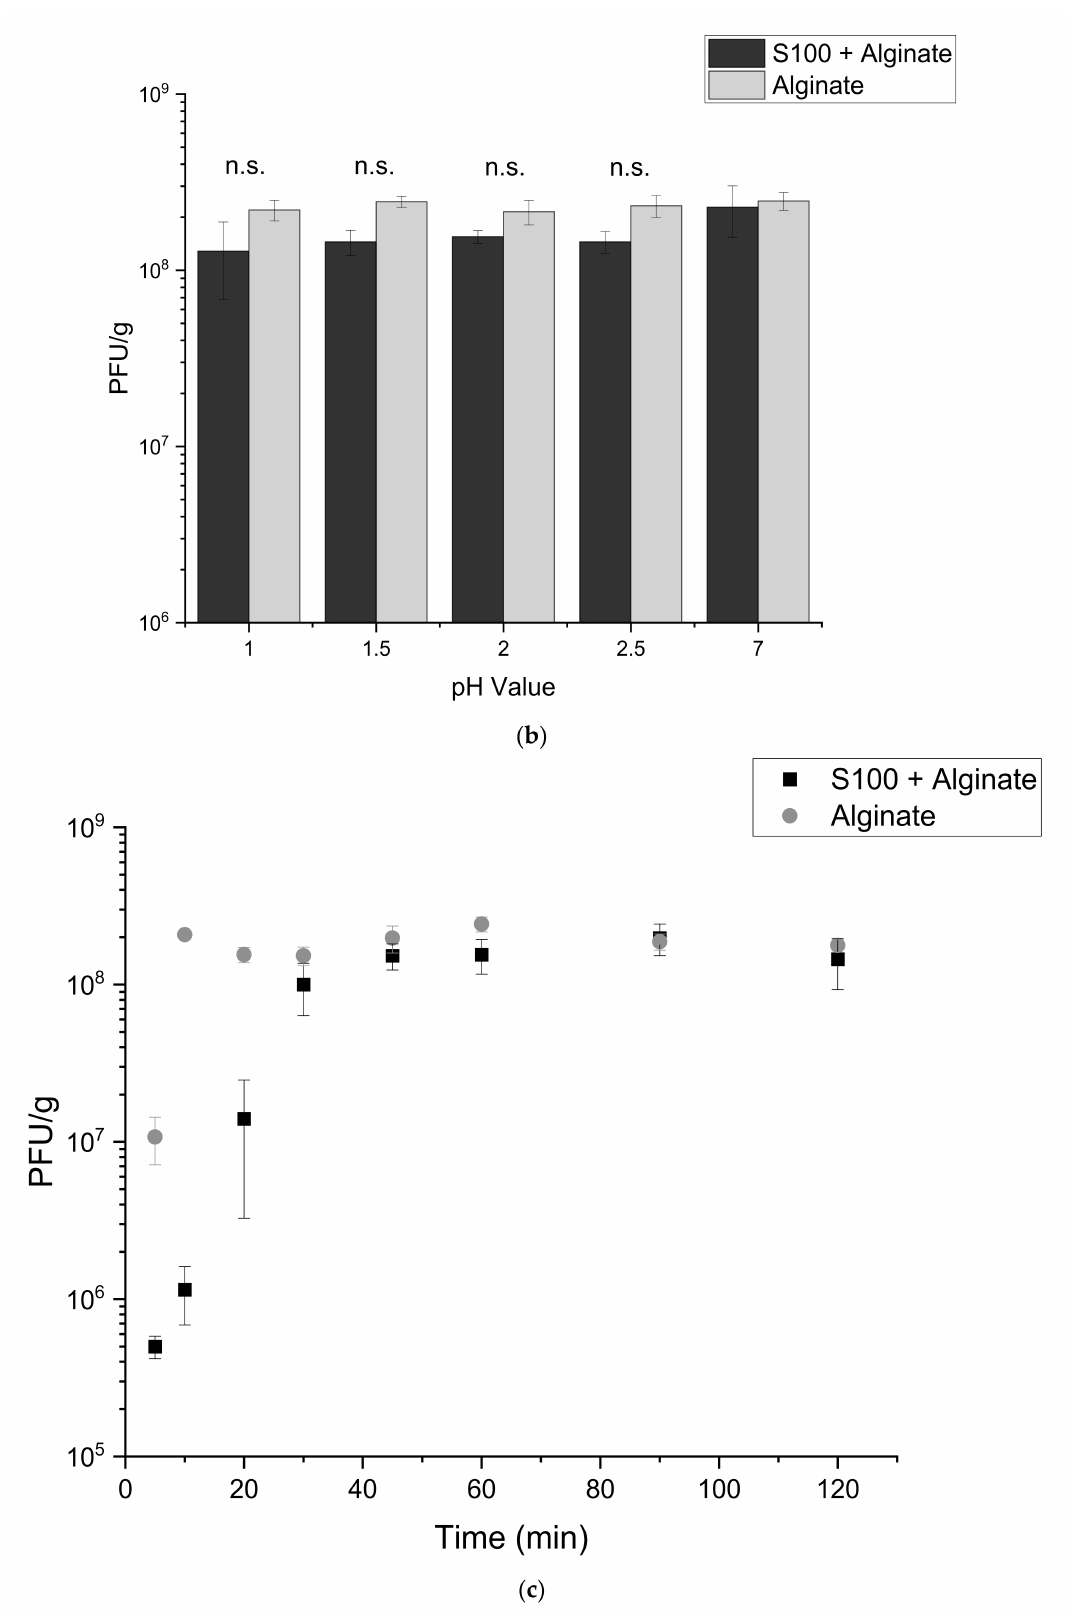
Figure 3. Acid stability of free phages and phages encapsulated in core-shell capsules. ( a ) Free phages were suspended in 0.2 M NaCl with pH adjusted to pH 2, 2.5, 3, 4, 5 and 6 (pH adjusted with HCl) at 37 ◦ C for up to 48 h. Time points were taken throughout and the final phage titre enumerated using the plaque assay. ( b ) Core-shell capsules exposed to